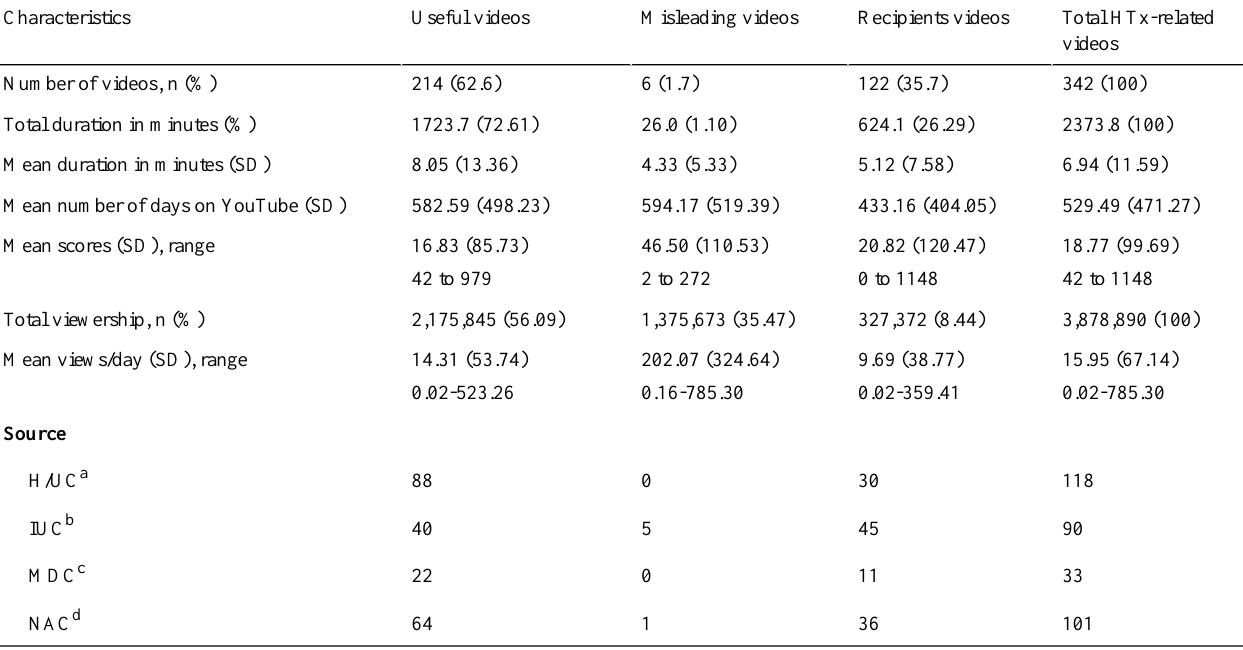
Table 2. Detailed characteristics of different categories of YouTube videos with relevant information on HTx.